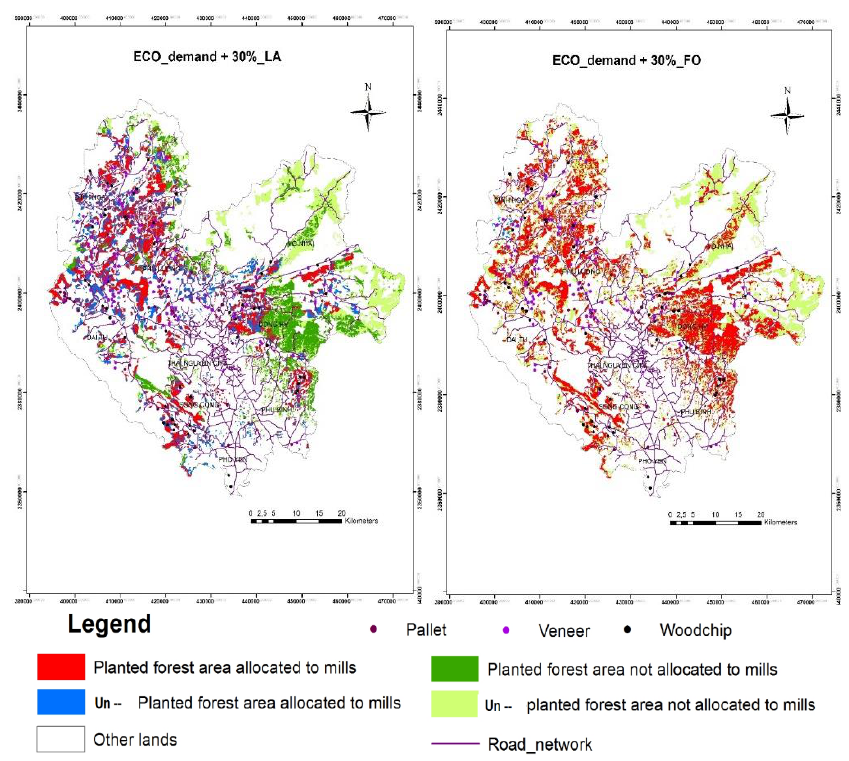
Figure 9. Spatial distribution of land area allocated by increasing timber demand 30% under the landscape approach (_LA) and the current forest approach (_FO).